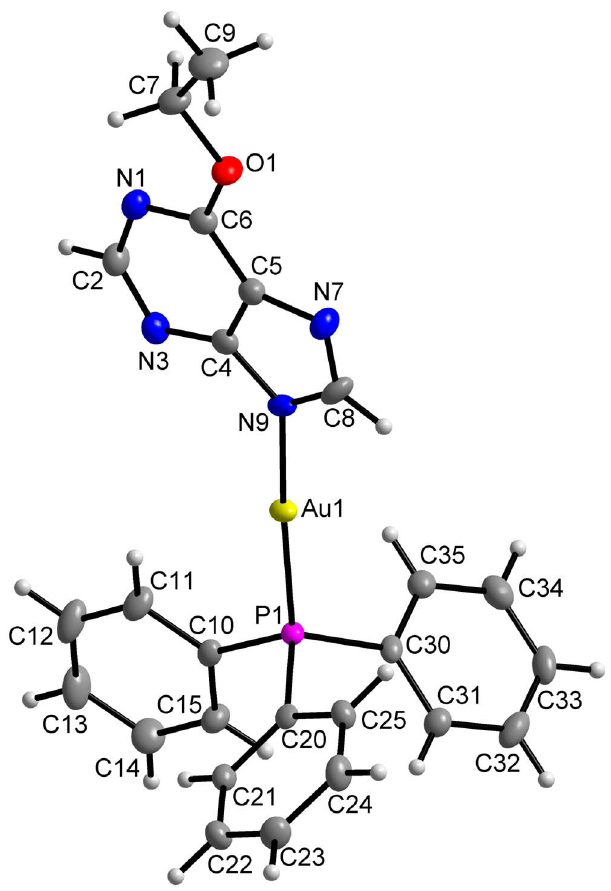
Figure 3. Molecular structure of [Au(L 1 )(PPh 3 )] (1). The molecular structure of 1 showing the atom numbering scheme. Non-hydrogen atoms are displayed as ellipsoids at the 50% probability level.